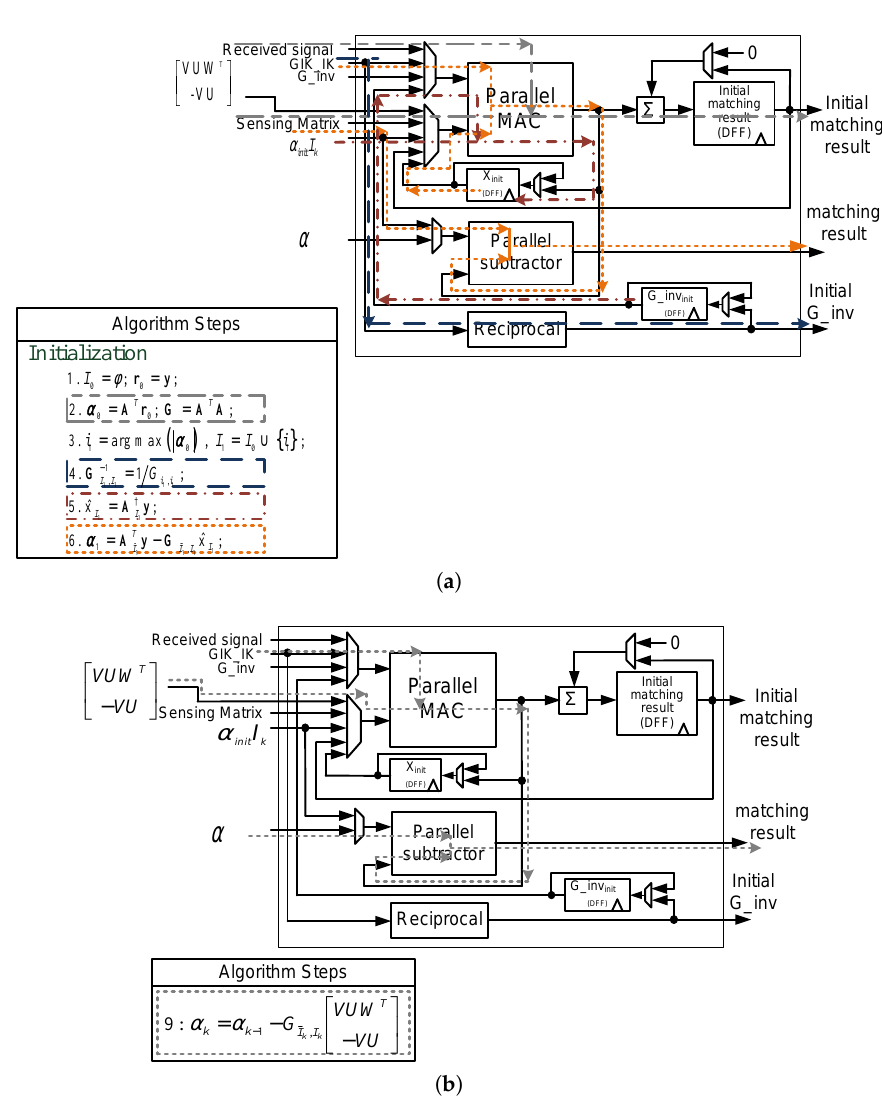
Figure 11. Processing flows of matching result update circuit for ( a ) initialization and ( b ) common matching result update in the data path